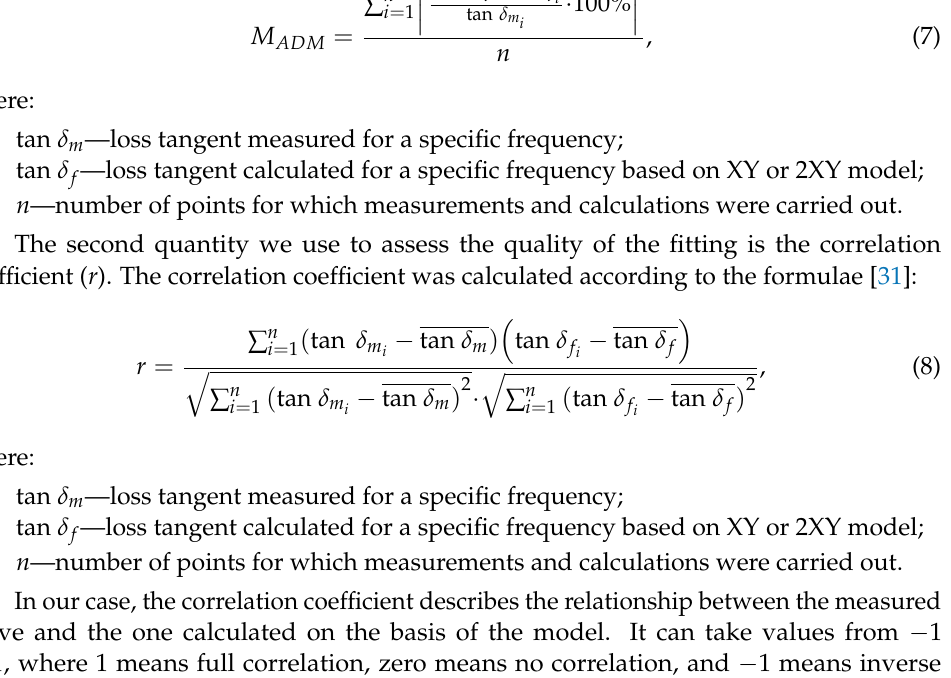
Figure 15. The dependence of the loss tangent on the frequency, measured for the COT type ( U n = 220 kV) bushing insulator and calculated based on the XY and 2 XY models, with the calculated relative differences between the measured and calculated values for both models.